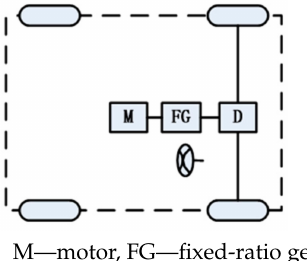
Figure 1. The motor centralized drive system.